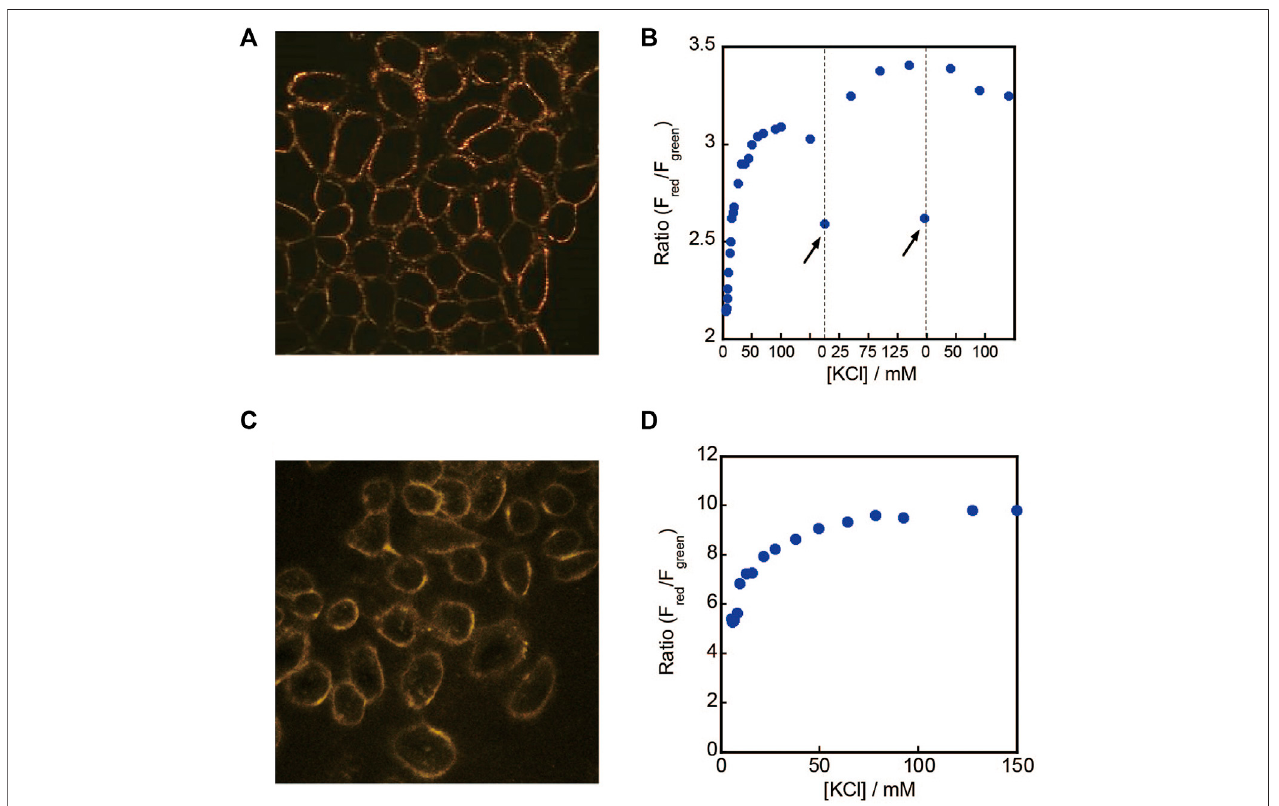
FIGURE 4 | (A) Extracell imaging by 1 -StAv-ConA, (B) fl uorescence ratio ofF red/ F green (F red : F.I. of 550 – 640 nm,/F green : F.I. of 495 – 540 nm) after adding KCl, λ ex = 488 nm. (C) Extracell imaging by 1 -StAv-sulfo-NHS-biotin, (D) fl uorescence ratio of F red/ F green after adding KCl, λ ex = 488 nm. ( ↑ ) indicates the change of DMEM